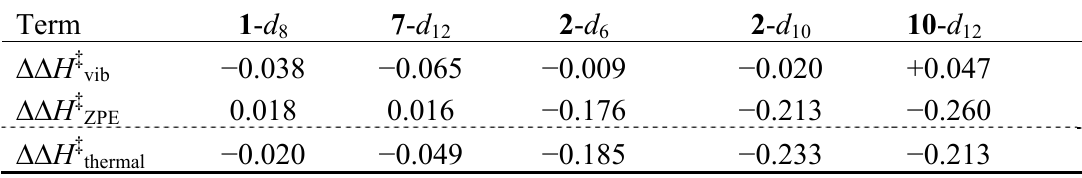
Table 5. Frequency-dependent enthalpic a KIE contributions (kcal/mol) for select systems. Term 1 - d